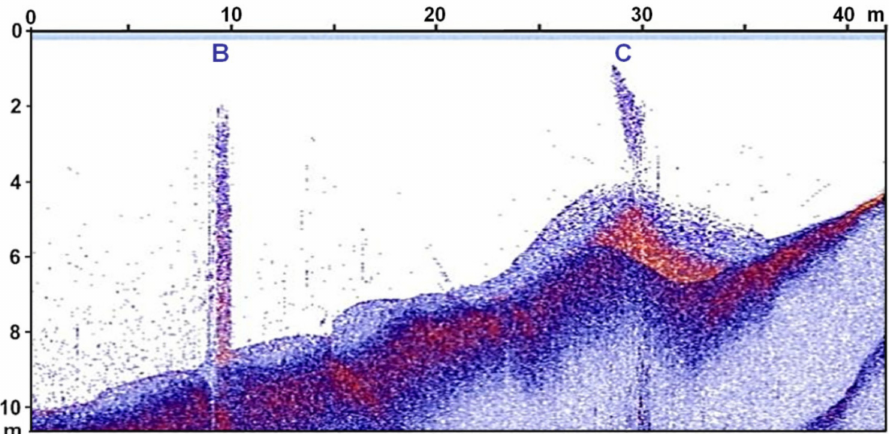
Figure 6. Echo sounding section with gas flares B and C on the Seyakha Crater, flooded by river water, 19 September 2019 (for location of section with B and C gas flares—see Figure